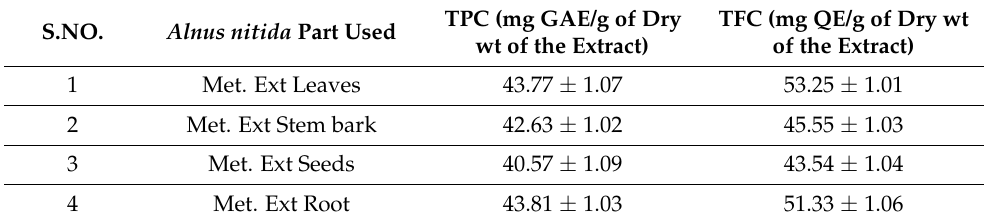
Table 1. Total phenolic content and total flavonoid contents in various parts of A. nitida . TPC (mg GAE/g of S.NO. Alnus nitida Part Used